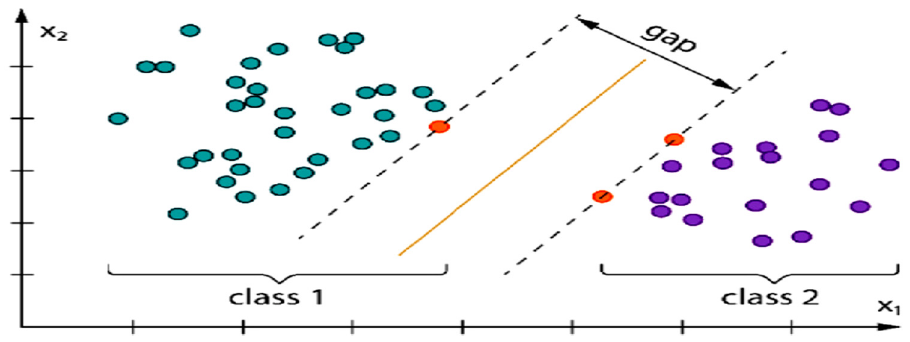
Figure 3. Idea of SVM classifier.